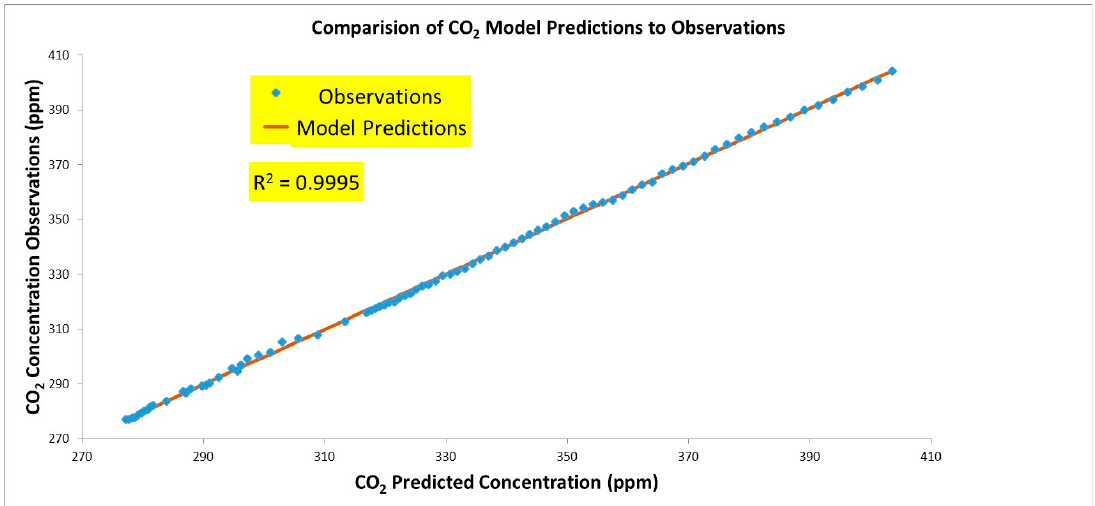
Figure 9. Comparison of predicted CO 2 atmospheric concentrations to observations.